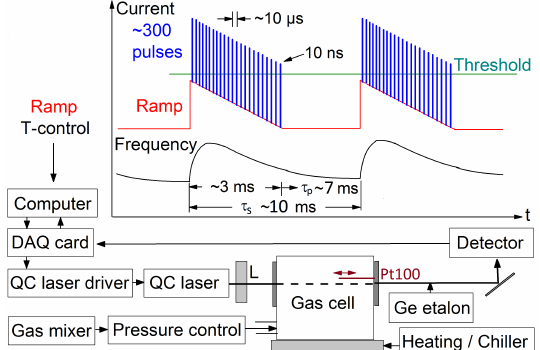
Figure 3. Scheme of inter pulse mode operation of QC lasers ( upper part) and the experimental setup ( lower part). L denotes an anti-reflection-coated aspheric